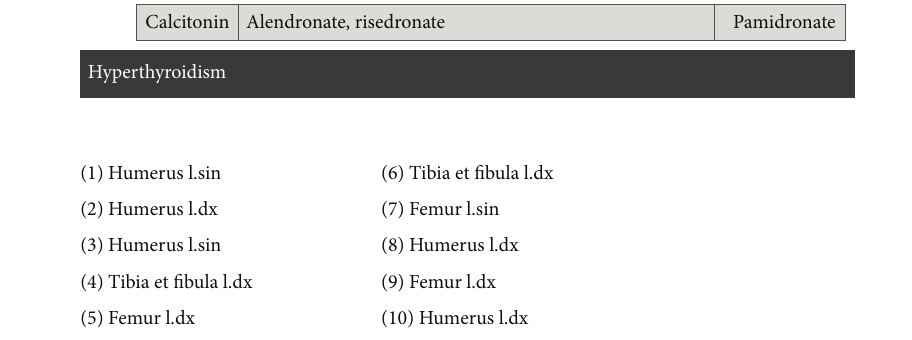
Figure 1: Timeline of the fractures and the relevant treatment from birth till present. Numbers 1 to 10 represent each one of the fractures; all of them occurred in affected parts of long bones. (1) Humerus l.sin, (2) humerus l.dx, (3) humerus l.sin, (4) tibia et fibula l.dx, (5) femur l.dx, (6) tibia et fibula l.dx, (7) femur l.sin, (8) humerus l.dx, (9) femur l.dx, and (10) humerus l.dx.